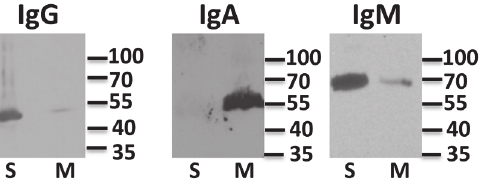
Fig 4. IgG, IgA, and IgM are present in Asian elephant milk and serum. Equal volumes of serum and milk were resolved by SDS-PAGE and then analyzed by immunoblot. Each blot was probed with antibodies specific for Asian elephant IgG, IgA, or IgM as indicated above each panel. Lanes containing serum (S) and milk (M) are labeled below each panel. Molecular weight markers are indicated to the right of the panels.